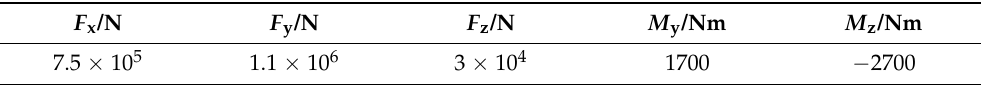
Table 2. Load parameters of the shaft